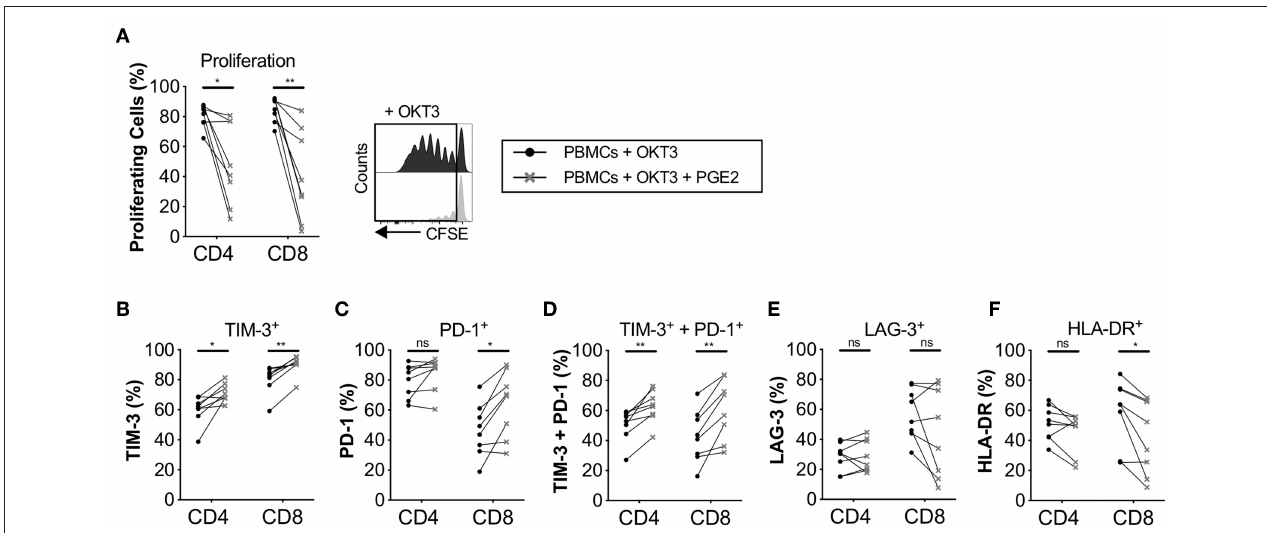
FIGURE 5 | PGE2 inhibits T-cell proliferation and upregulate co-inhibitory markers on proliferating T-cells. CFSE-labeled PBMCs were cultured in the absence (•) or presence ( × ) of 0.1 µ g/ml PGE 2 and stimulated with OKT3 (25ng/ml) for 5 days ( n = 8). (A) Frequency of proliferating CD4 + and CD8 + T-cells (left). Representative CFSE histograms on CD4 + T-cells (right). Expression of (B) TIM-3, ( C ) PD-1, (D) TIM-3 and PD-1 (E) LAG-3, and (F) HLA-DR on proliferating T-cells. Lines between dots indicate paired samples. Wilcoxon matched-pairs signed rank test was used to detect statistically significant differences * P < 0.05, ** P < 0.01, ns (not significant).